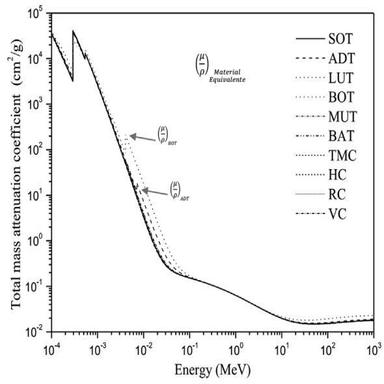
Behavior of the total mass attenuation coefficient for the different equivalent materials manufactured in the energy range from 50 eV to 1 GeV calculated by PENELOPE code.